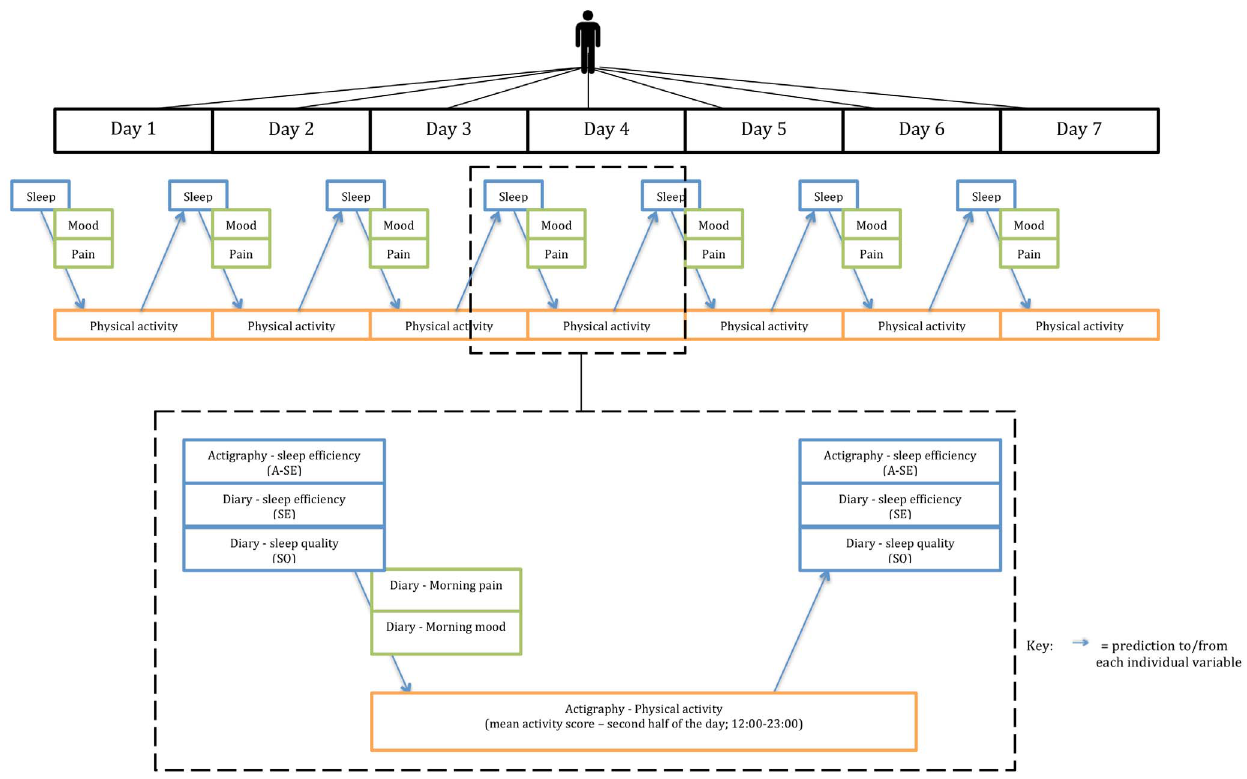
Figure 1. Design and analysis plan of the study.